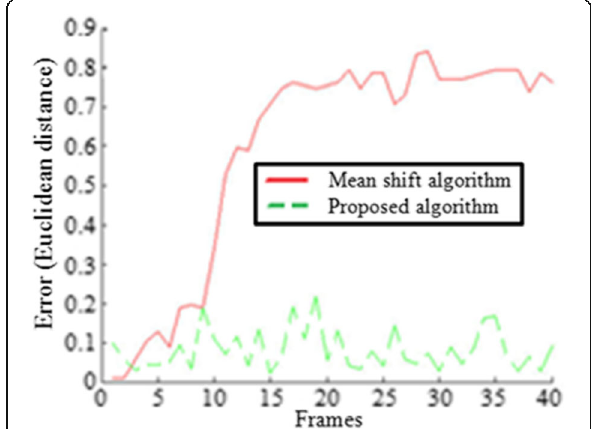
Fig. 18 Tracking error graph of CAVIAR database set (image sequences of Fig. 16)